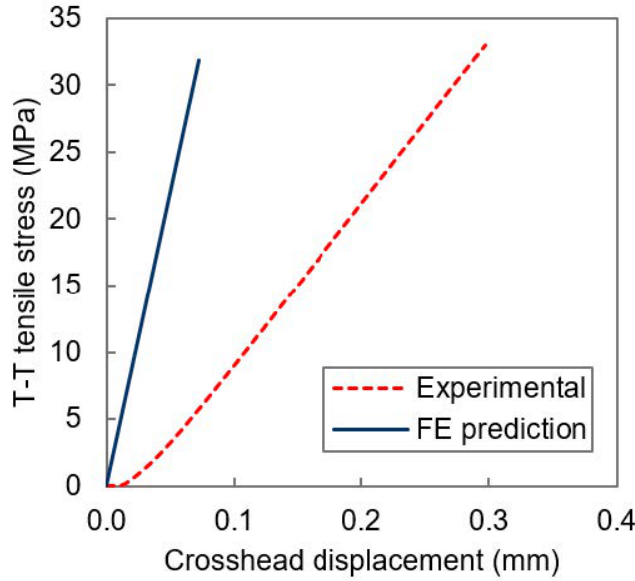
Figure 13. Experimental and FEA predicted stress–displacement curves for the cruciform